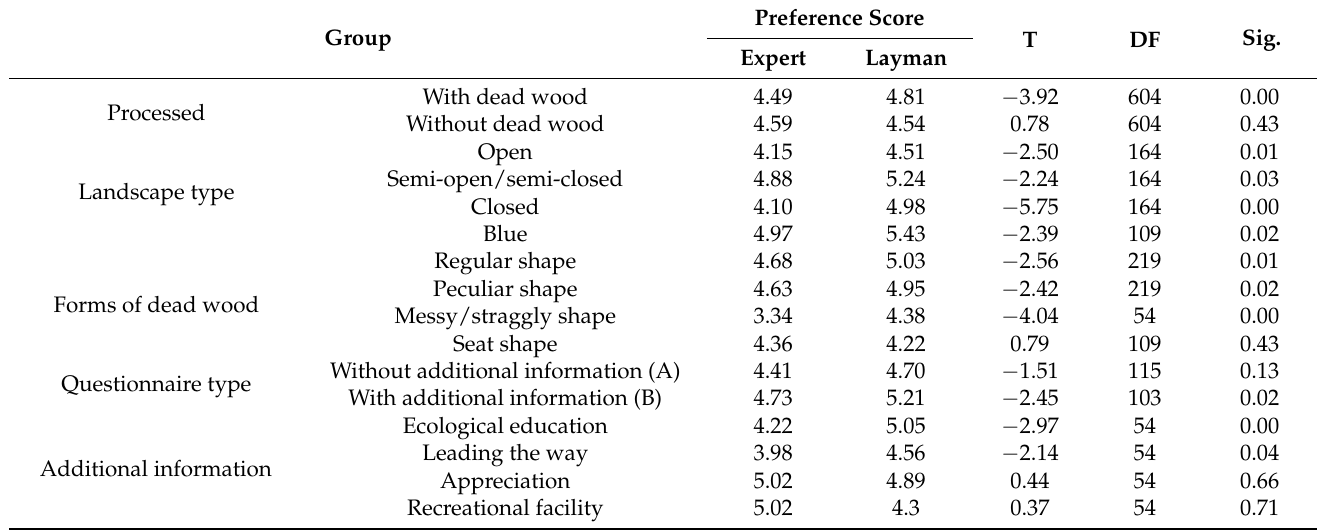
Table 7. Results of the two sample T-tests of the effects of professional background on the preferences for dead wood.